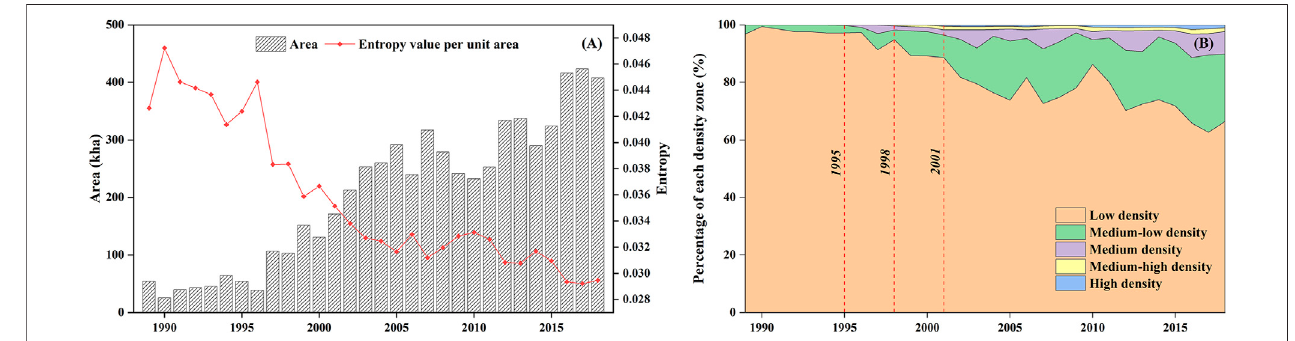
FIGURE 3 | The spatial clustering patterns of GCL: (A) the spatial information entropy, (B) the spatial distribution density.